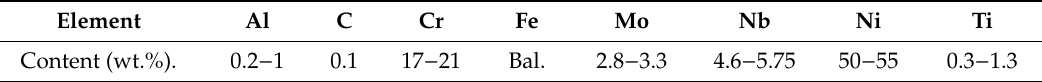
Table 1. Chemical composition of Inconel 718 (wt.%). Element Al C Cr Fe Mo Nb Ni Ti Content (wt.%). 0.2 − 1 0.1 17 − 21 Bal. Table 2. UNSM (ultrasonic nanocrystal surface modification) and thermal processing details of Inconel 718. Sample Treatment I1 Annealed at 675 ◦ C for 2 h I2 Annealed at 1000 ◦ C for 10 min, water quenched, repeated 3 times I3 UNSM treated, repeated 3 times